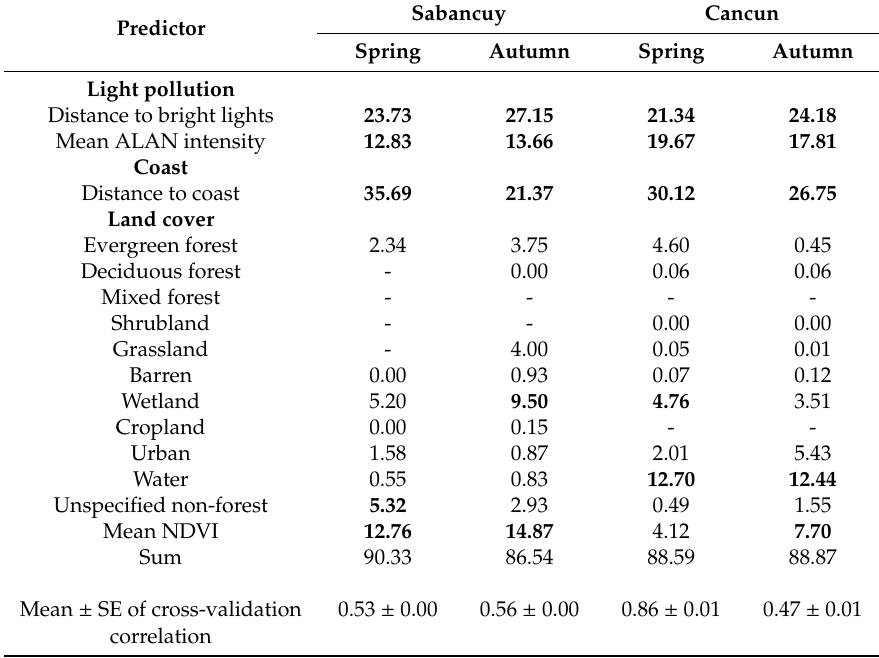
Table 3. Relative variable influence of biological predictors (i.e., excluding distance to radar and relative elevation) of bird stopover densities from the Boosted Regression Tree models by radar and season, and sum of the top five predictors, indicated in bold font. Also shown are the mean ± standard error (SE) of cross-validation correlations for each